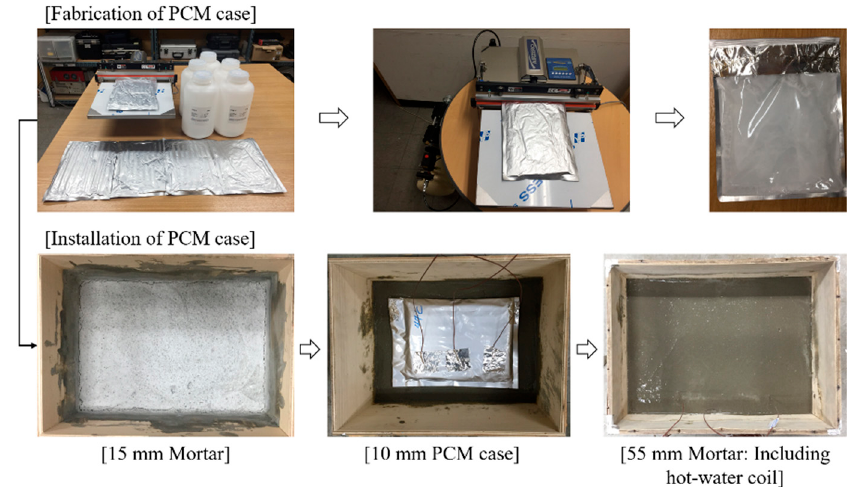
Figure 2. The fabricating progress and the application to the floor of the PCM case.